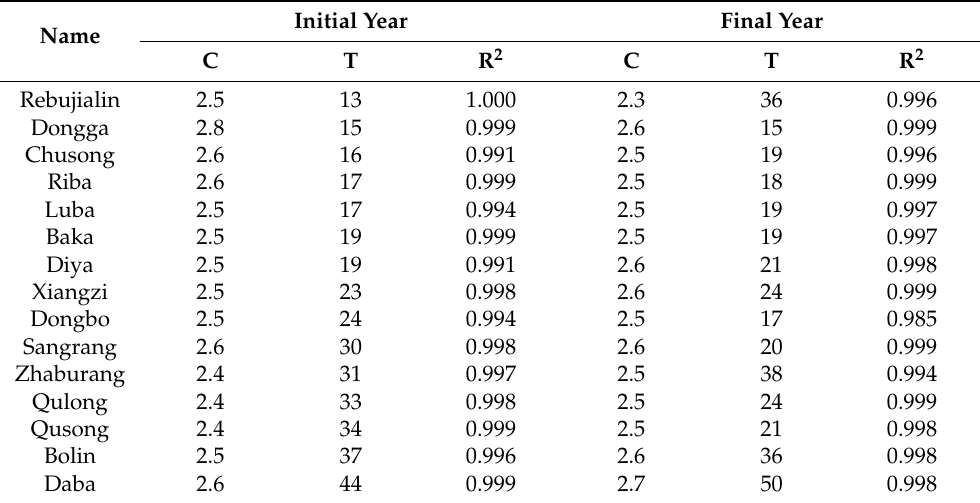
Table 2. Parameters of the fitted rural settlement scale growth